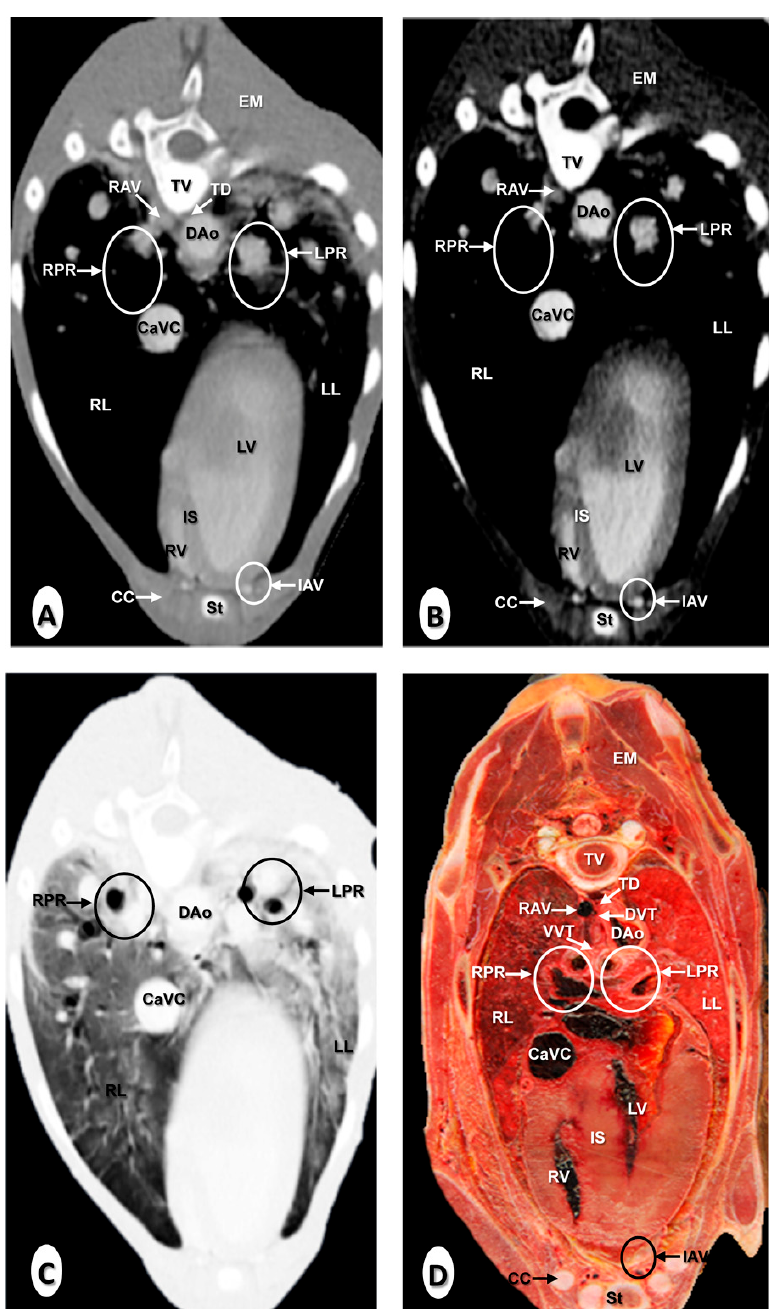
Figure 6 . Transverse images at the level of the left ventricle. ( A ) CT bone window; ( B ) CT mediastinal window; ( C ) CT lung window; and ( D ) anatomical section. These images are displayed so that the right side of the foal is to the viewer’s left and the dorsal view is at the top. Caudal vena cava (CaVC); descending aorta (Dao); dorsal vagal trunk (DVT); epaxial muscles (EM); internal thoracic artery and vein (IAV); interventricular septum (IS); left lung (LL); left pulmonary root (LPR); left ventricle (LV). rib: Costal bone (R); rib: Costal cartilage (CC); right azygos vein (RAV); right lung (RL); right pulmonary root (RPR); right ventricle (RV); sternum (St); thoracic duct (TD); thoracic vertebra (TV); and ventral vagal trunk.